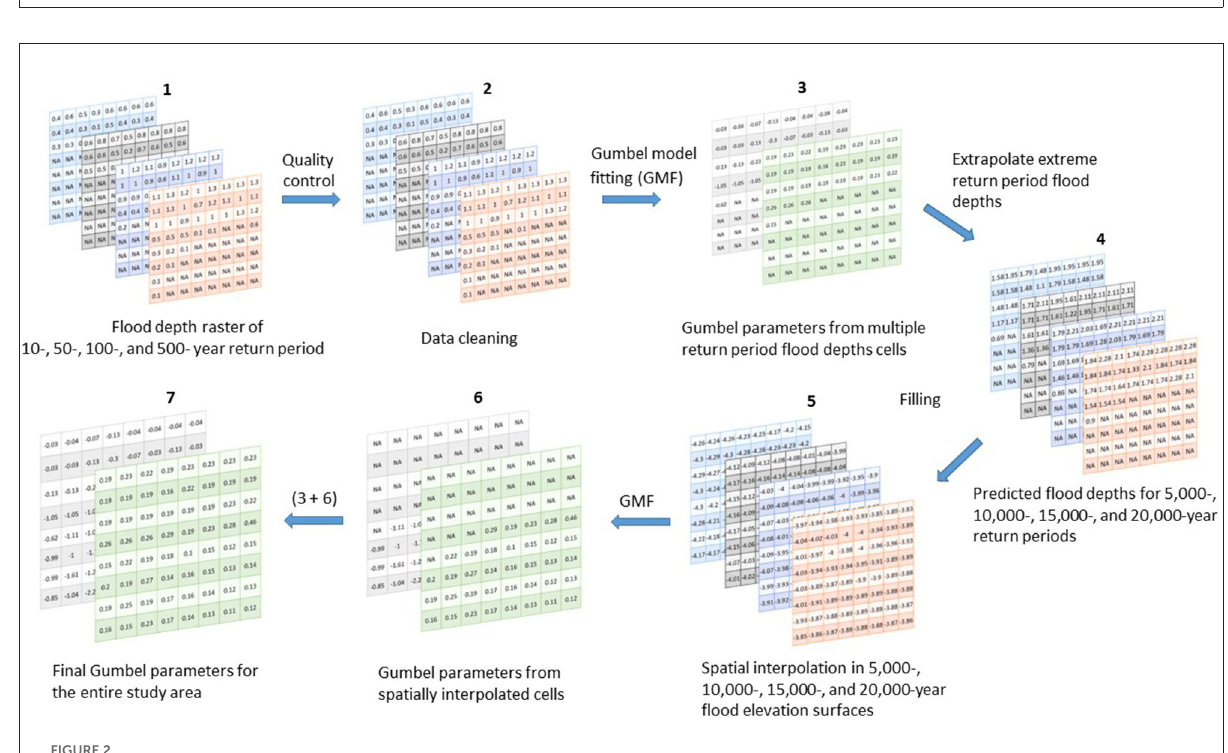
FIGURE2 Schematic summary of the flood hazard characterization